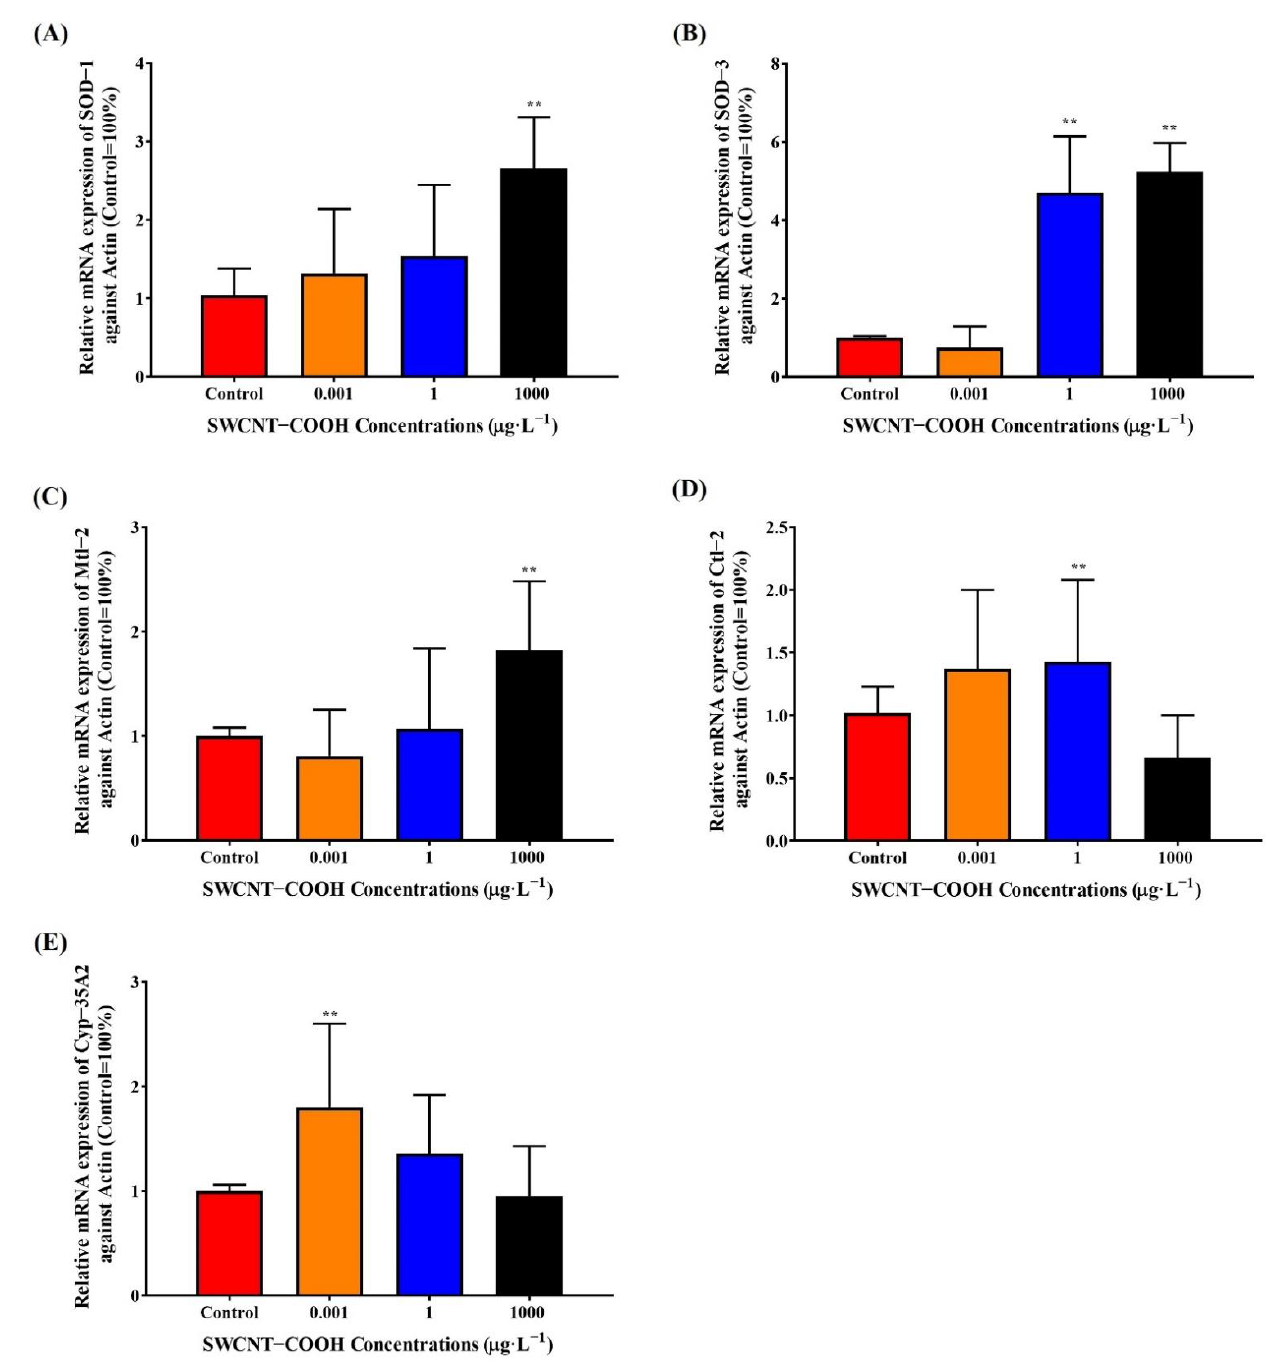
Figure 6. Effects of SWCNTs−COOH on the mRNA expression of SOD-1 ( A ), SOD-3 ( B ), mtl-2 ( C ), ctl-2 ( D ), and cyp-35A2 ( E ) in C. elegans after 8 days of exposure. ** p < 0.01 as compared with the control.